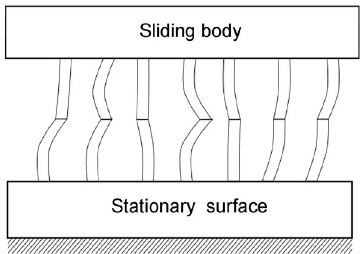
contacting surfaces interact through bristles